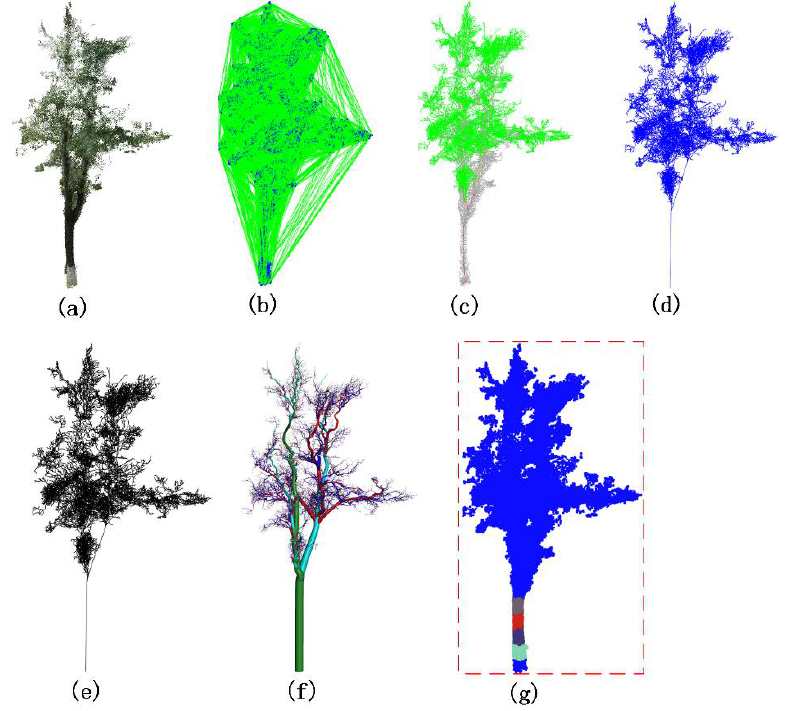
Figure 5. The process of modeling individual tree TP point clouds by AdQSM. ( a ) TP point clouds, ( b ) Delaunay triangulation, ( c ) weighted all edges and constructed minimum spanning tree, ( d ) skeleton initialization, ( e ) skeleton simplification, ( f ) fitting tree branch cylinder, ( g ) automatic identification of point cloud in modeling process.